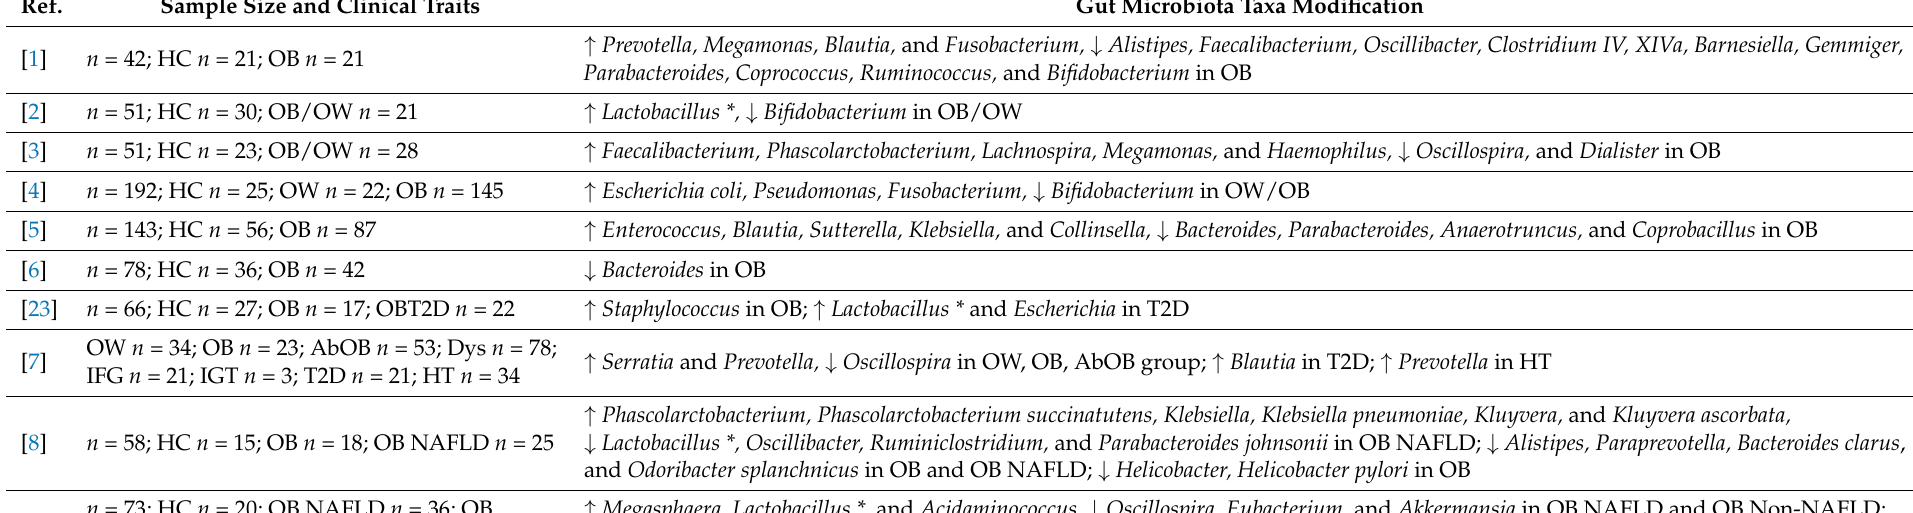
Table 1. Changes in the main microbiota taxa found in patients suffering metabolic-related diseases.